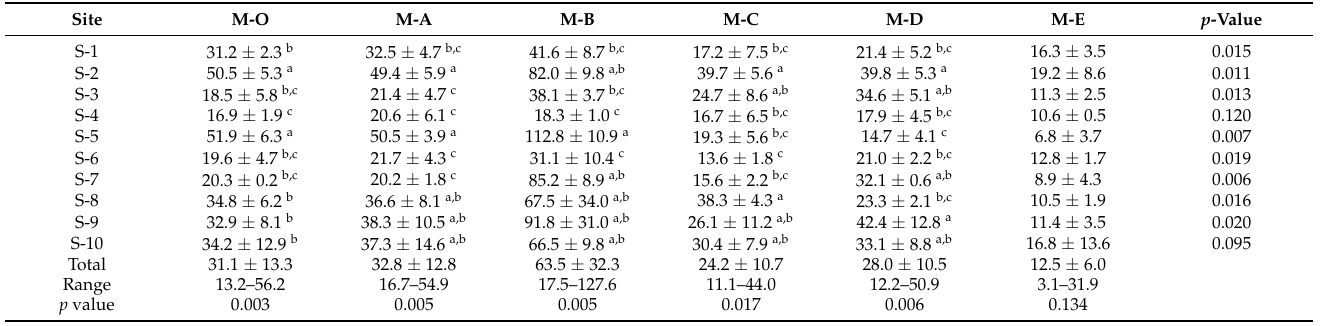
Table 4. The [Cu]/[DOC] ratios ( µ mol/g-C) of bulk and size-fractioned AEOM solutions at each